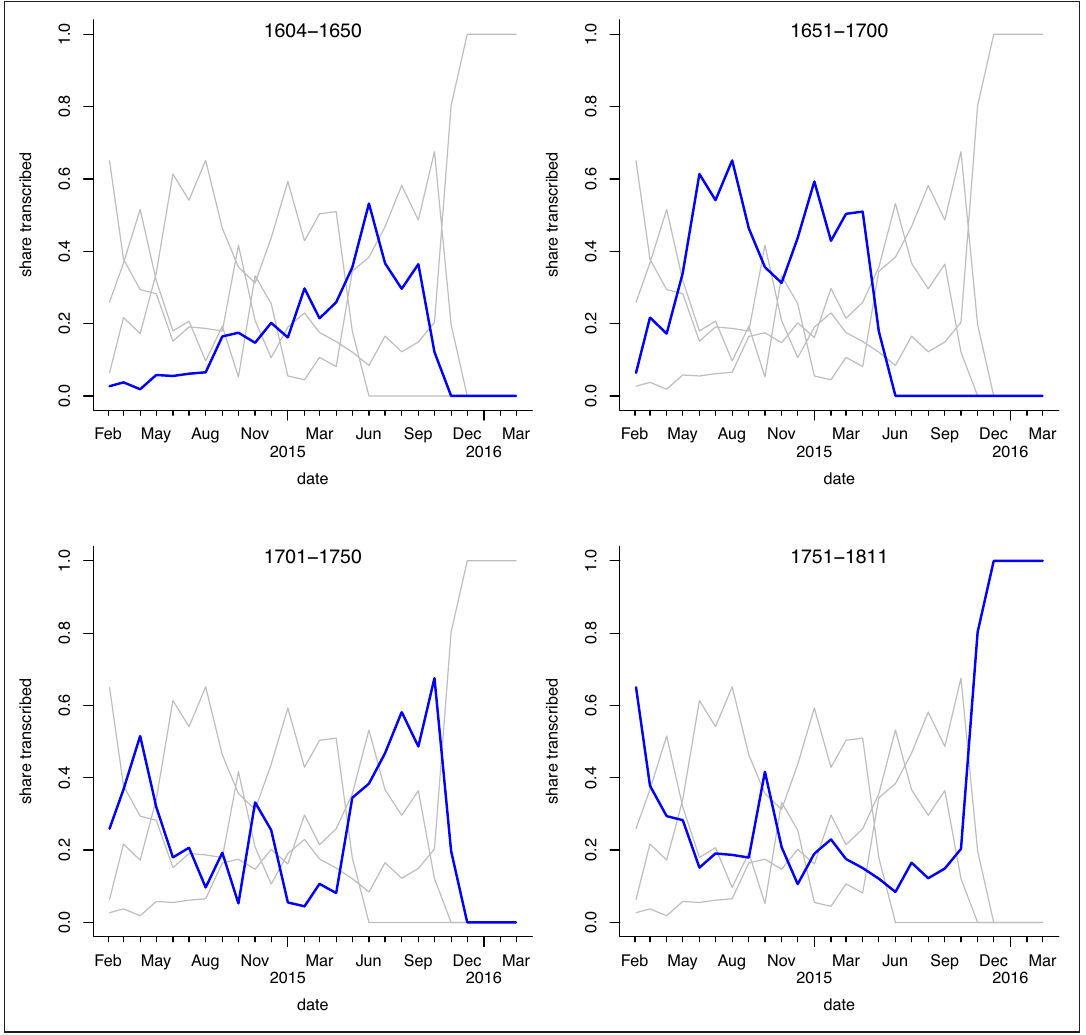
Figure 7: Monthly shares of types of transcribed scans tracked throughout the project. Blue lines trace the share of the total scans for the panel’s period; grey lines in the background show the shares for the other periods to facilitate comparisons. Table 6: Overview of paleography workshops offered throughout the